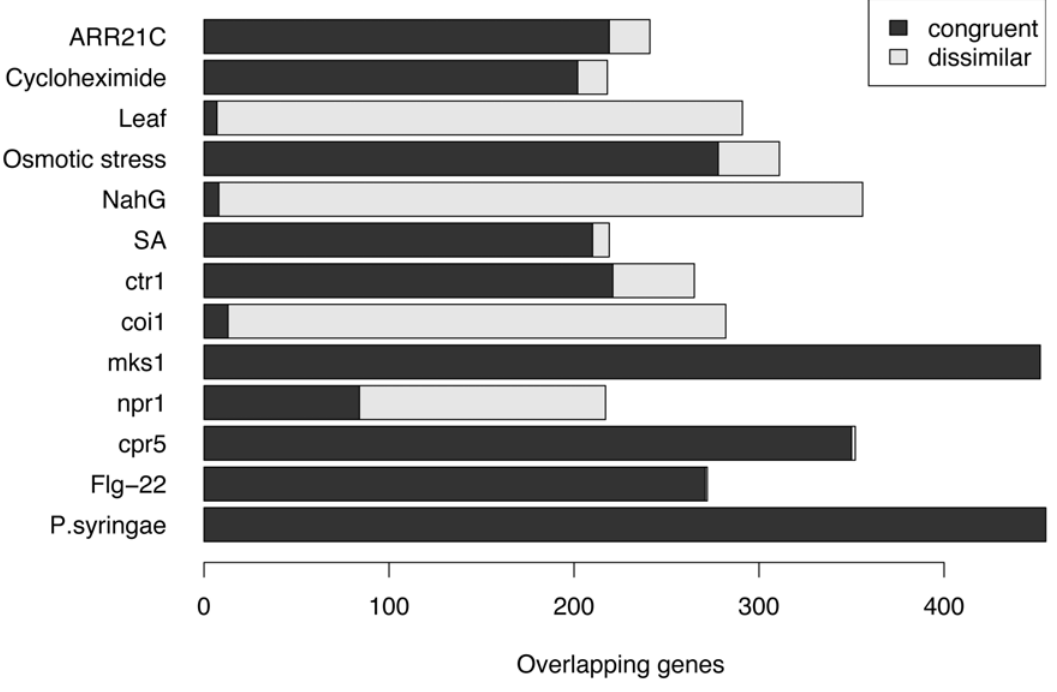
Figure 3. Bar plot of gene expression congruence and dissimilarity. The response overlap between mpk4 and selected experimental factors are shown. The dark and light areas of the bars indicate congruent and dissimilar gene expression between mpk4 and an experimental factor, respectively.